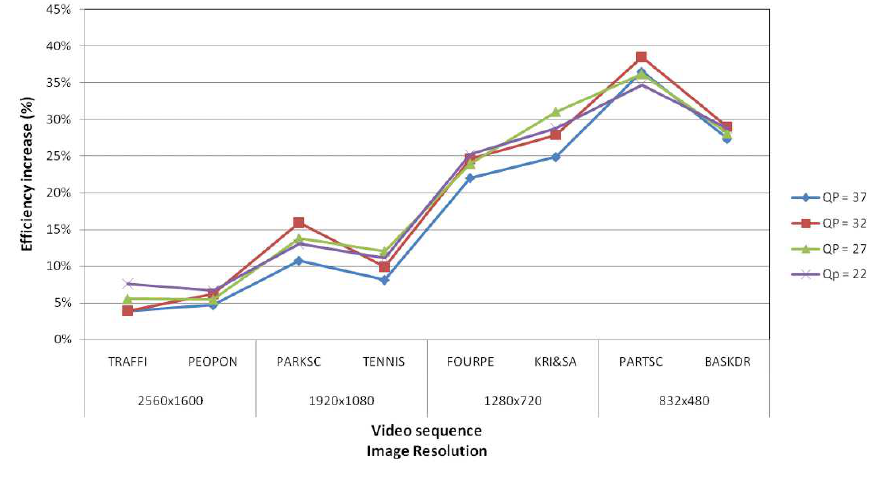
Figure 11. DSM-AI vs. tile-based efficiency